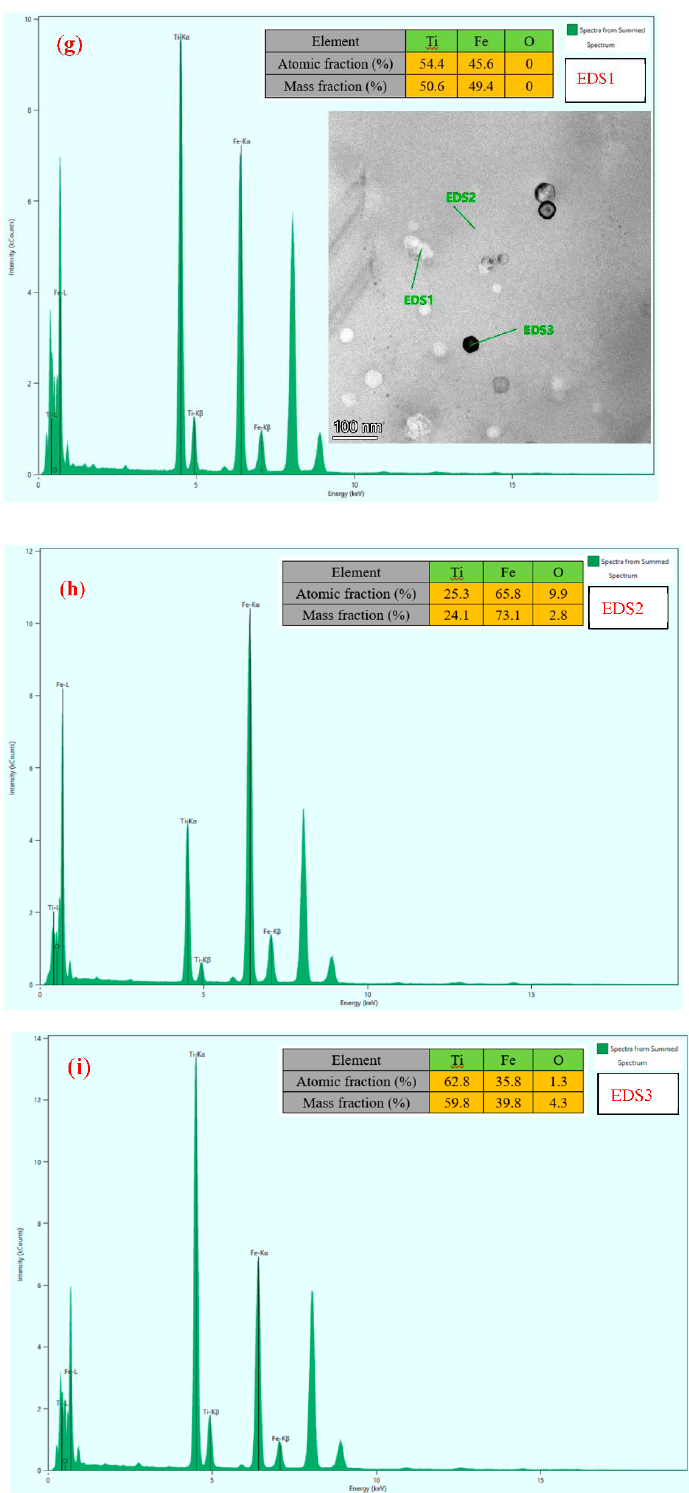
Figure 4. TEM result of melting zone of the crest at the TA2/Q235 interface: ( a ) TEM sample cut perpendicular to the melting zone; ( b ) TEM sample prepared by FIB; ( c ) TEM bright field image; ( d ) EDS map scanning under the TEM bright field; ( e ) the selected area electro diffraction (SAED) showing formation of different phase in the melting region; ( f ) EDS line scanning under the TEM bright field; ( g ) EDS1 point scanning, ( h ) EDS2 point scanning and ( i ) EDS3 point scanning under the TEM bright